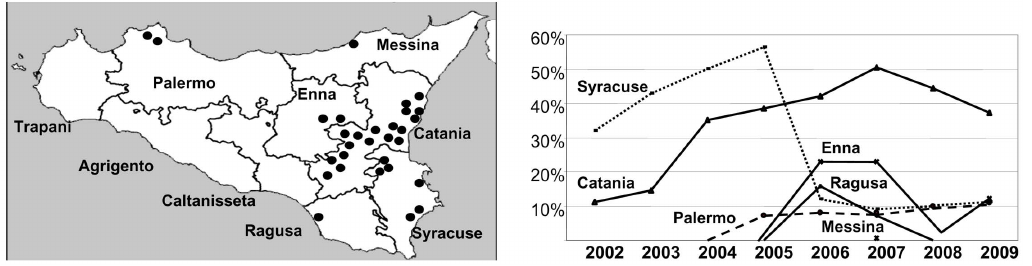
Figure 1. Incidence (percentage of CTV-infected citrus trees) per year in each of the eight Sicilian provinces from 2002 to 2009.